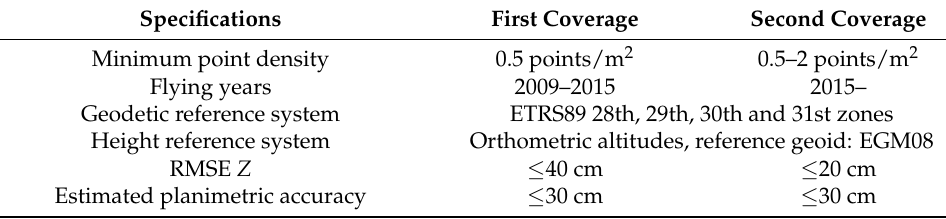
Table 1. Technical specifications of the public airborne LiDAR data.